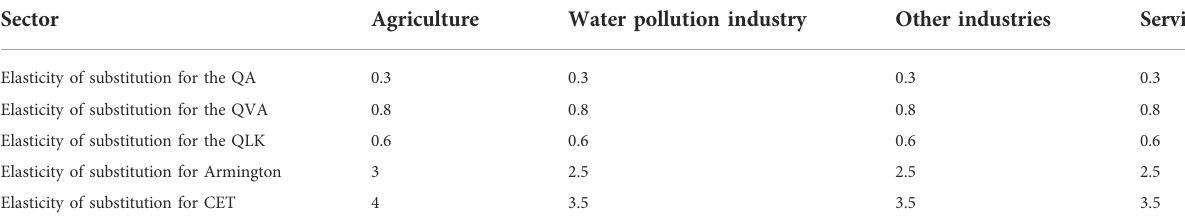
TABLE 1 Main elastic parameters of the model.